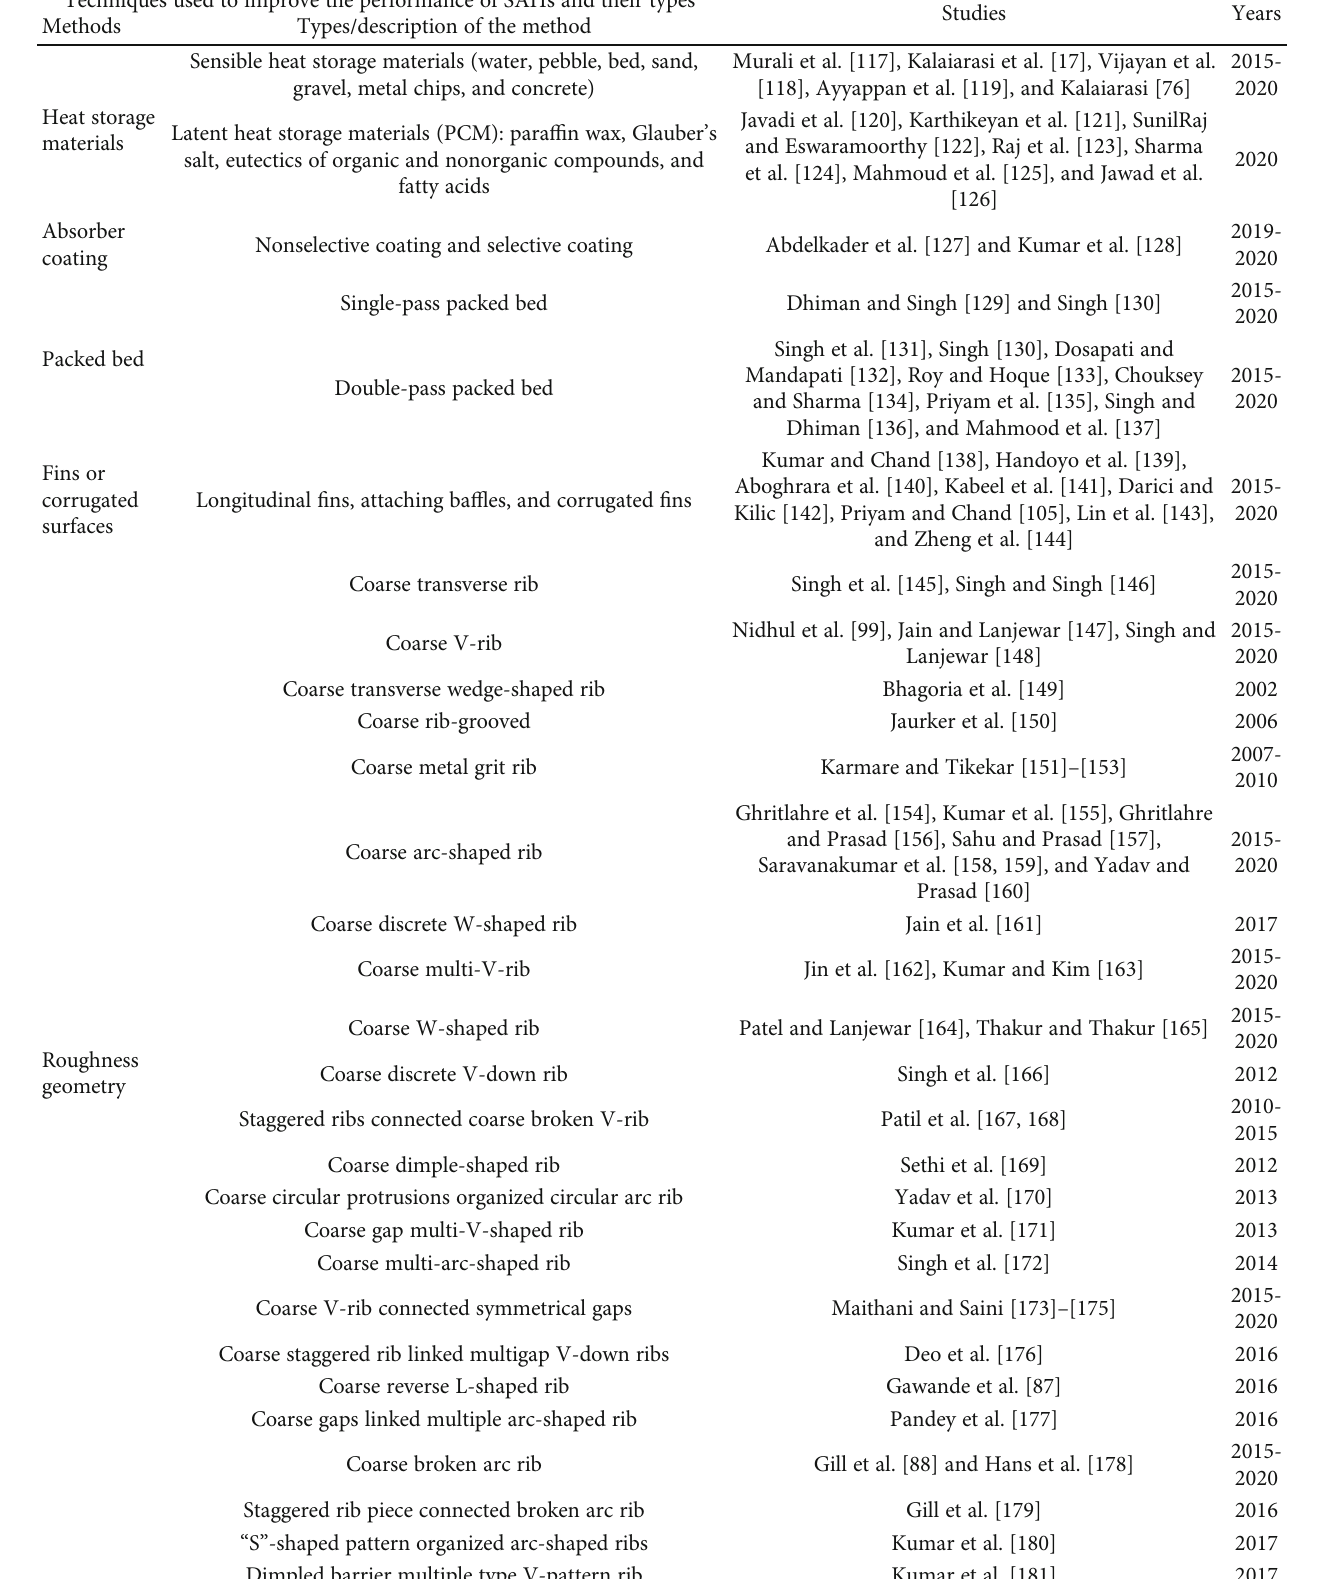
Table 3: Summary of very recent research studies on techniques used to improve the e ffi ciency of SAHs. Techniques used to improve the performance of SAHs and their